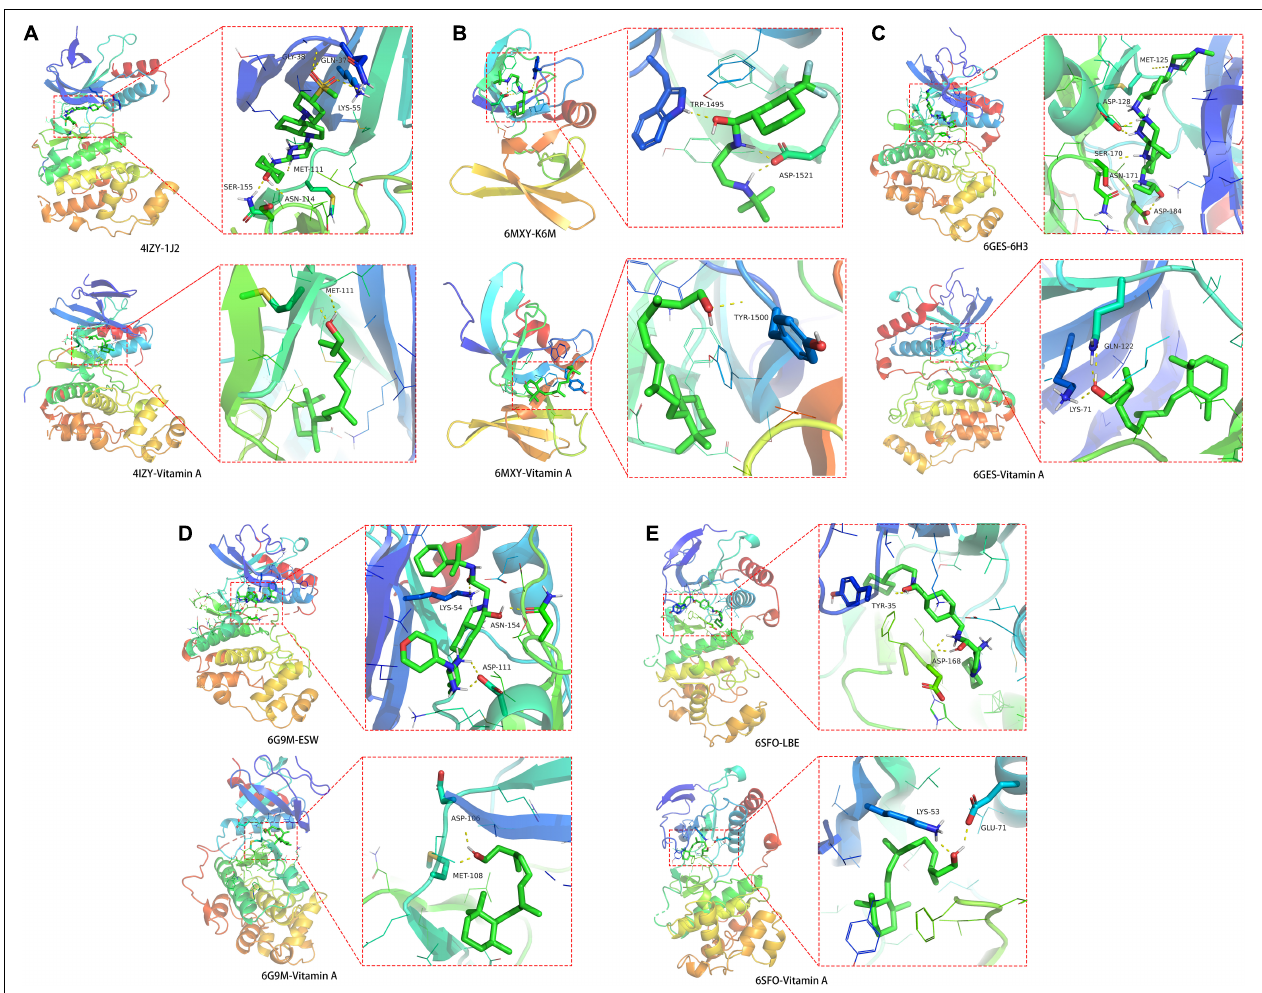
FIGURE 6 | Molecular docking details of (A) JUN-4IZY; (B) TP53-6MXY; (C) MAPK3-6GES; (D) MAPK1-6G9M; and (E) MAPK14-6SFO in VA action with core target